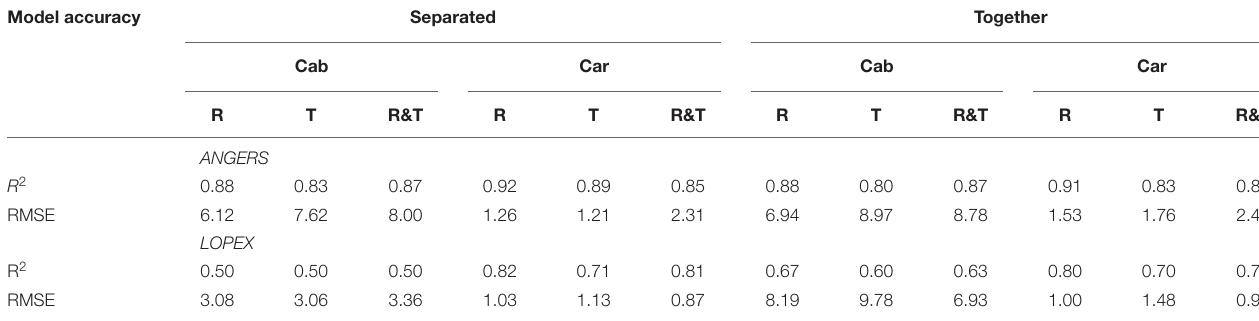
TABLE 3 | The optimal R 2 and their corresponding RMSEs for the FW-ANN models selected from five different bands. Model accuracy Separated Together Cab Car Cab Car R T R&T R T R&T R T R&T R T